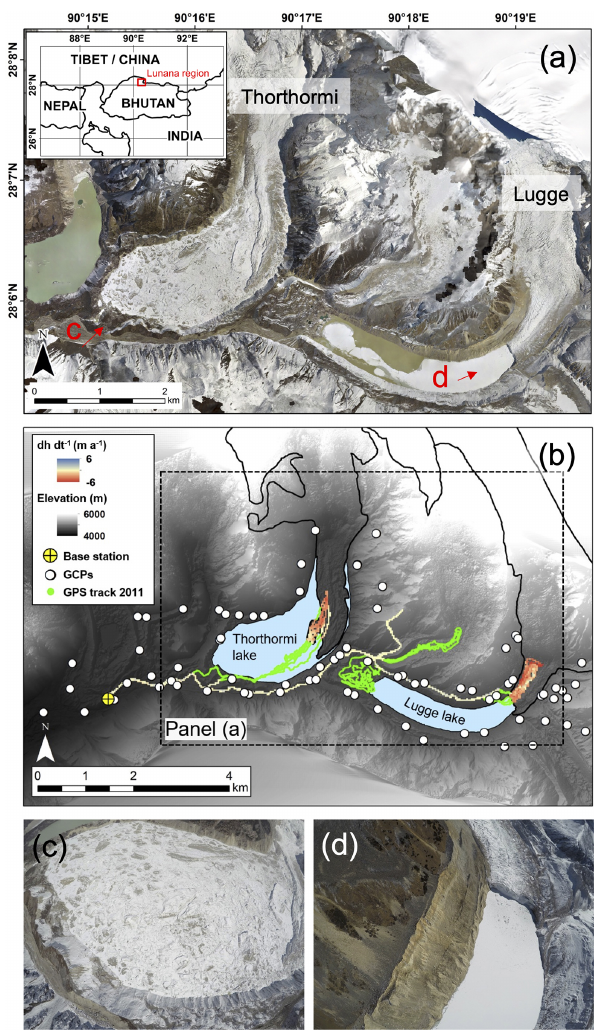
Figure 1. Details of the study site. (a) Location of the Lunana region (inset) and helicopter photogrammetry (HP) orthoimage of Thorthormi and Lugge glaciers (acquired on 24 March 2018). (b) Surface elevation map generated from the HP-DEM using ground control points (GCPs) for terrain data processing (open cir- cles) and 2011 GPS tracks (dots). (c, d) Aerial photographs of Thorthormi and Lugge glaciers. Red arrows in panel (a) indicate the directions from which the aerial photographs were taken. The dashed box in (b) shows the domain of (a) . The green GPS track in (b) was not used for the DEM accuracy check or elevation change